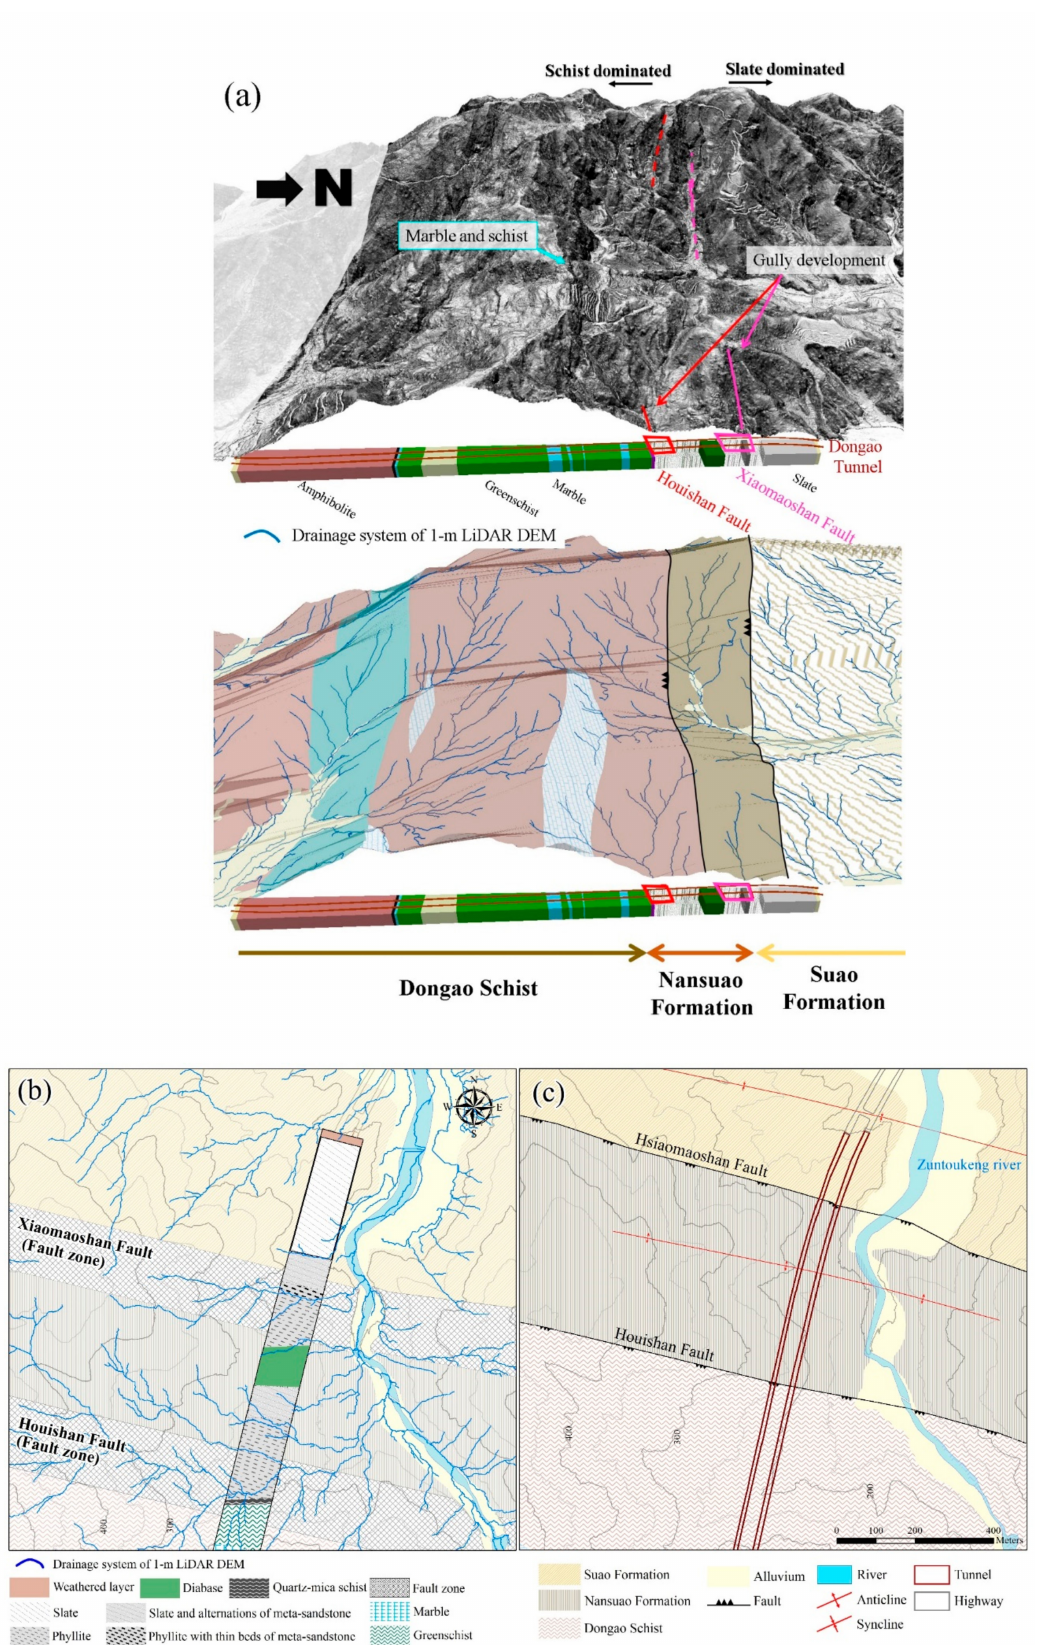
Figure 11. Lithological distribution along the north section of the Dongao Tunnel ( a ) and a refined geological map ( b ). Conventional geological map of a similar area is enlarged ( c ) for